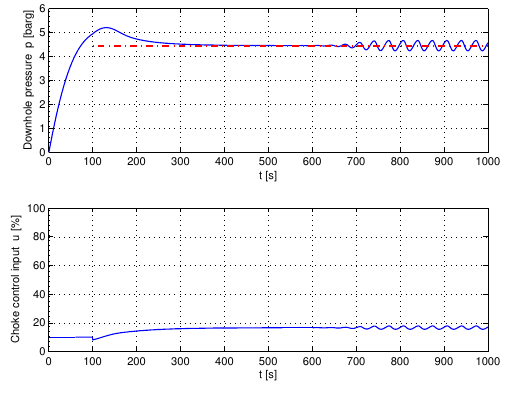
Figure 6: Simulations of an attempt to stabilize at a pressure in the unstable region p ref = 4 . 45 using PI